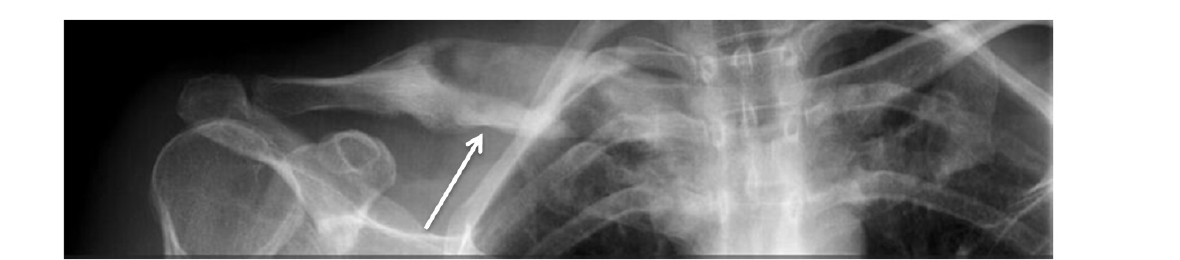
Figure 3. Coronal T2-weighted MR scan image reveals aggressive mid-clavicular lesion with hyperintense signal within the medullary cavity (long arrow) and surrounding inflammation in the soft tissues (short arrows).